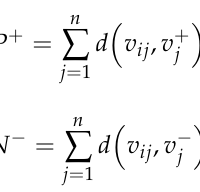
Step 5: Estimation of the positive and negative solution The ideal positive ( P + ) and negative ( N − ) solutions are calculated using Equations (2) and (3). The result obtained is shown in Table 10.